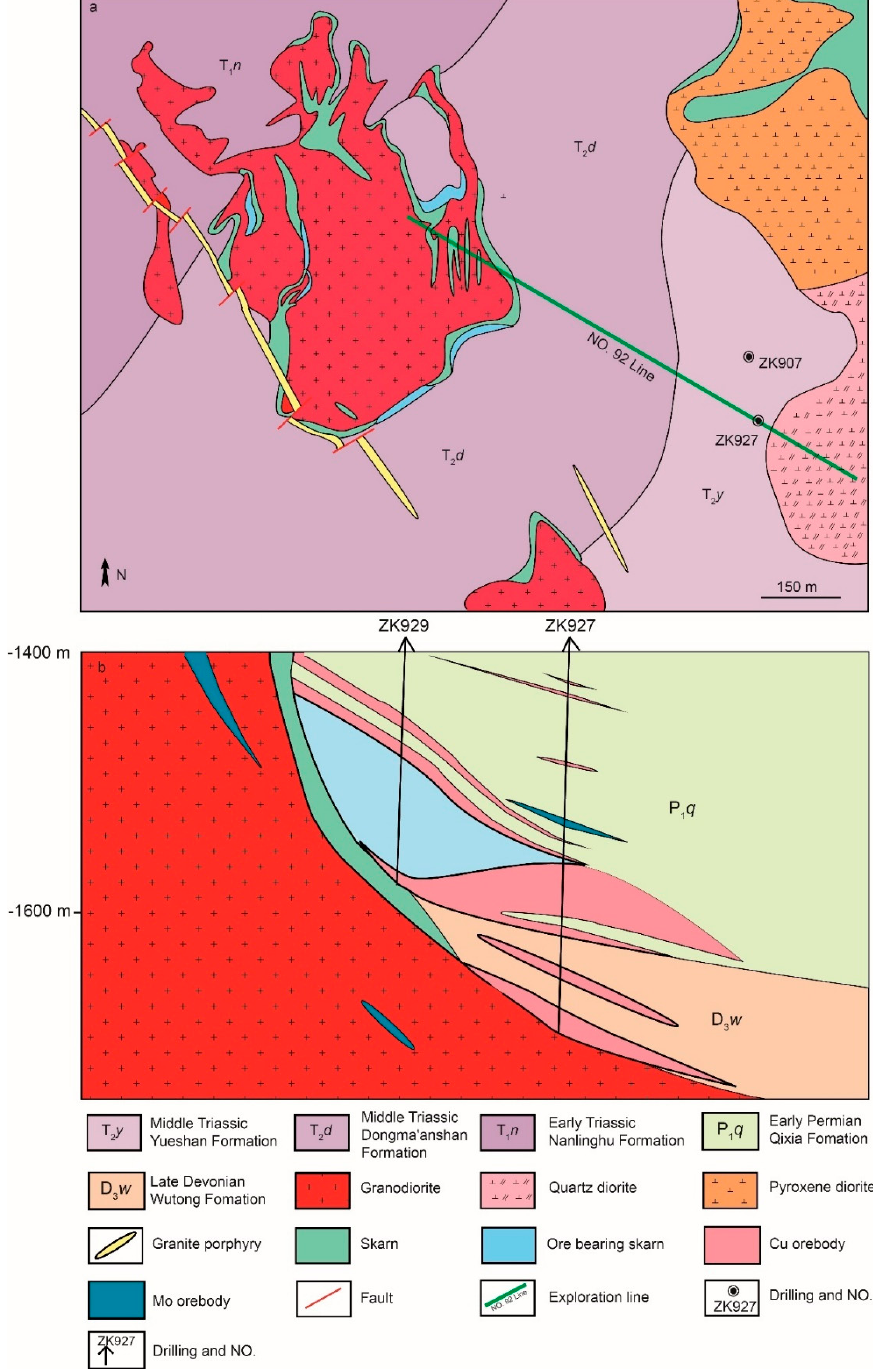
Figure 2. ( a ) Modified geological sketch map of Hucunnan area; ( b ) drilling geological profile of Hucunnan Cu–Mo deposit [45].